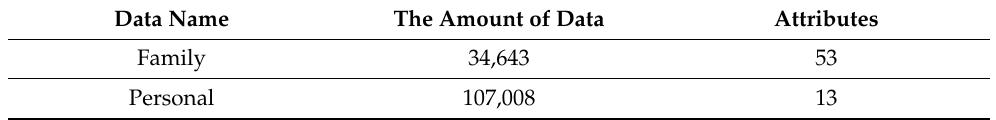
Table 11. Preprocessed China household finance survey data.